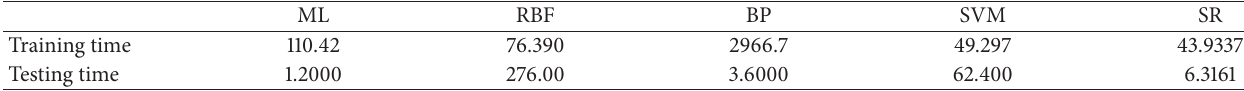
Table 5: Time-consumption of different algorithms (in second).